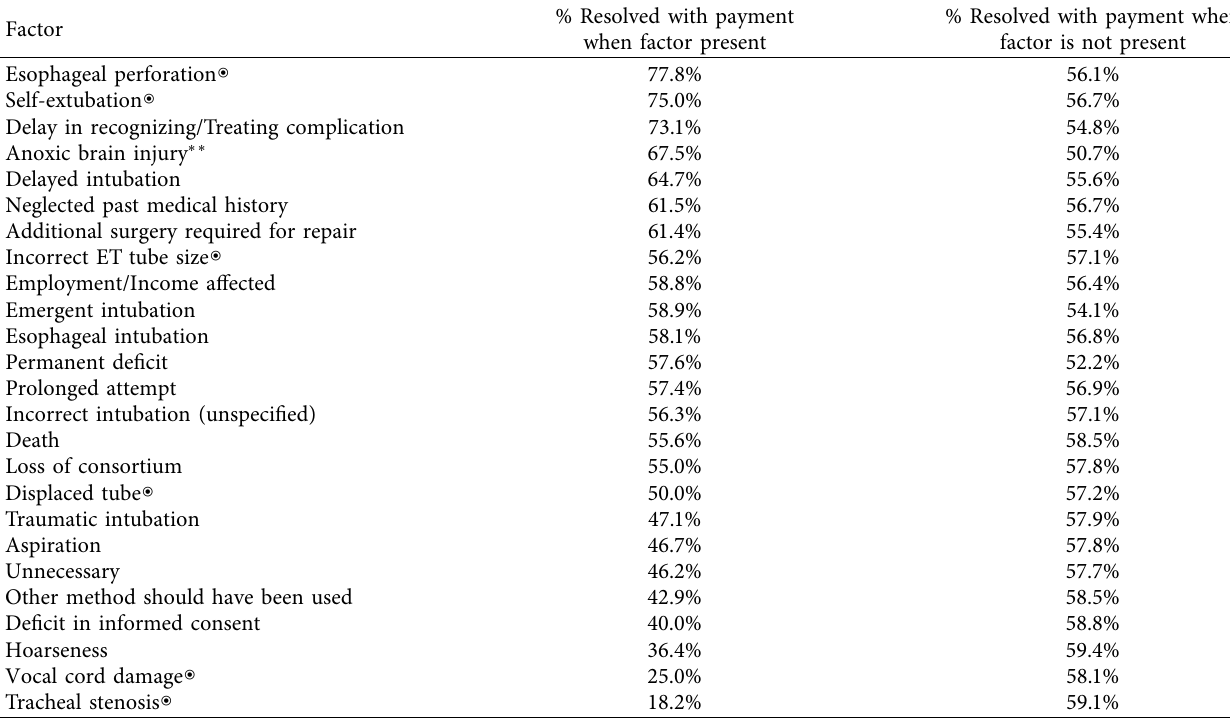
Table 1: Prevalence of factors mentioned in cases organized by outcome.